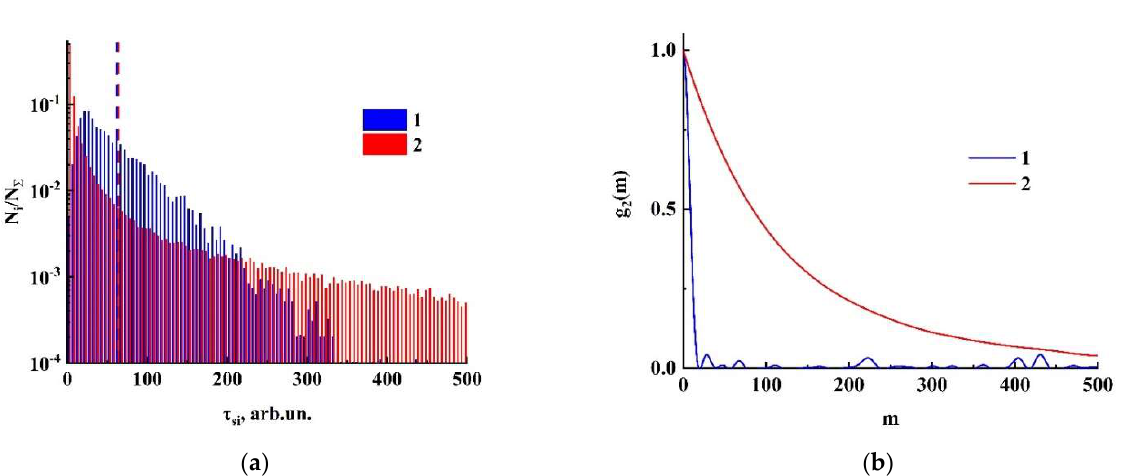
Figure 7. Histograms of the speckle lifetimes ( a ) and the corresponding normalized correlation functions of intensity fluctuations ( b ) for the considered ensembles of phasors. Assignment of the markers (1, 2) is the same as in Figure 6.